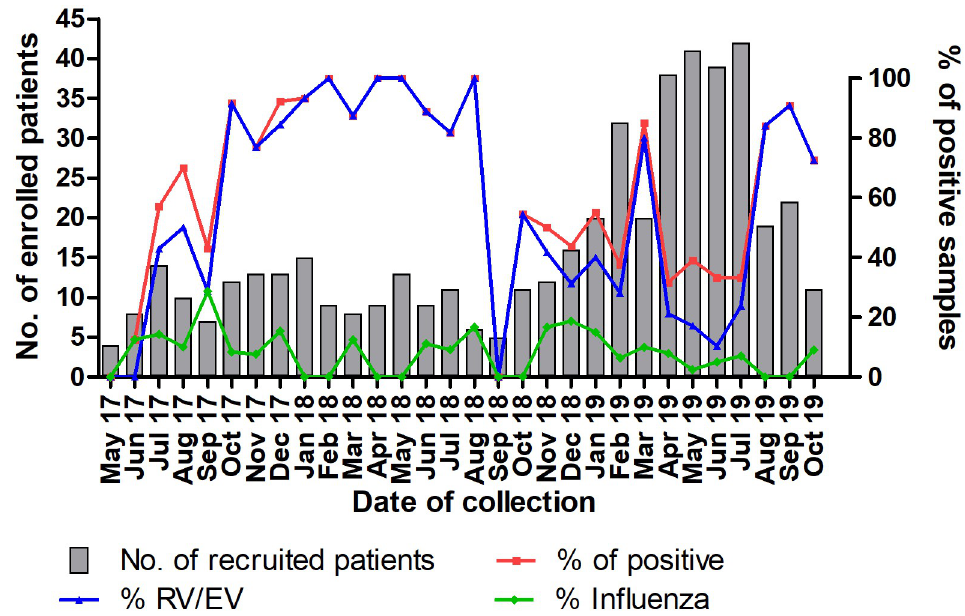
Fig 1. Seasonal distribution of rhinovirus/enterovirus and influenza virus in SARI adult